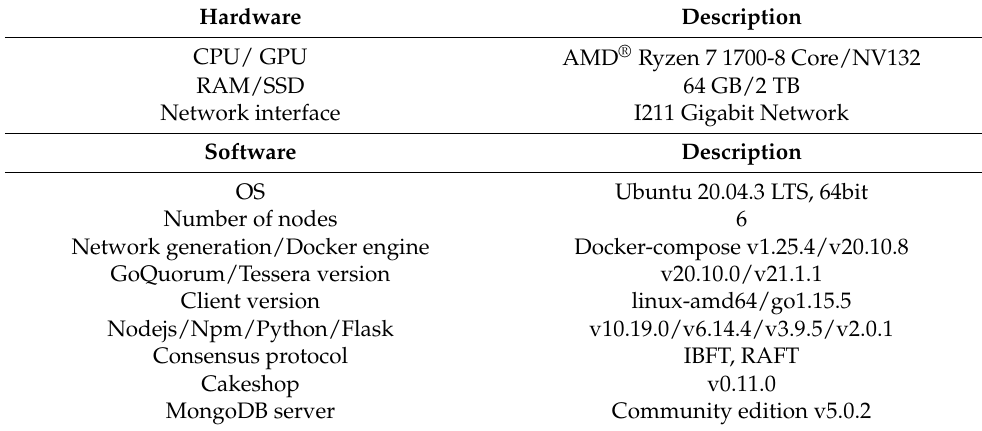
Table 4. Experiment environment setup.